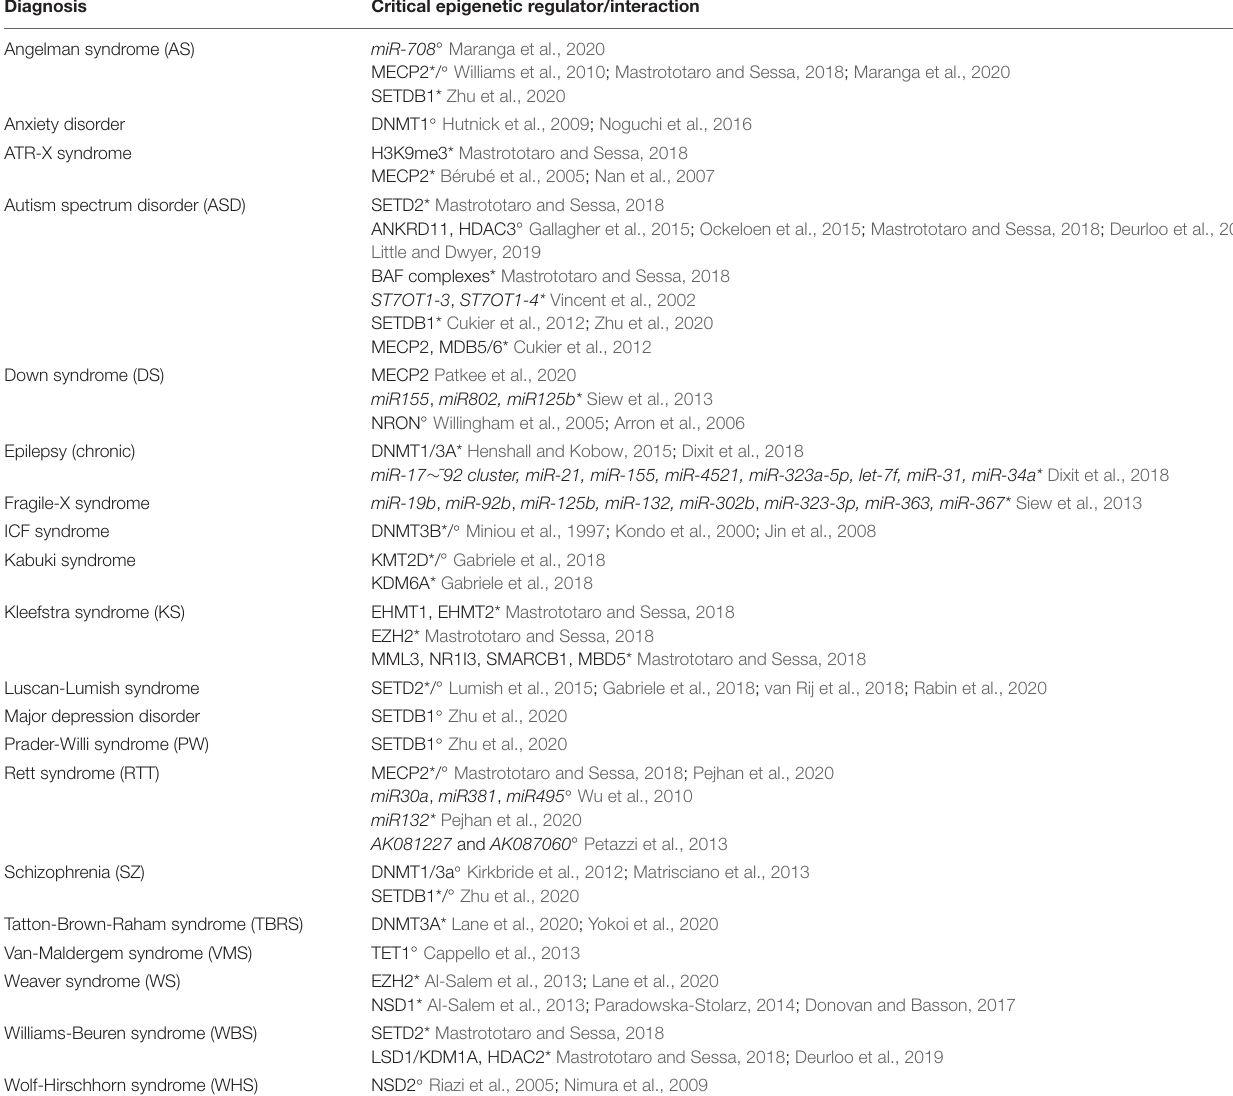
TABLE 2 | Overview of epigenetic key players associated to different NDDs as revealed from studies in humans and mice.